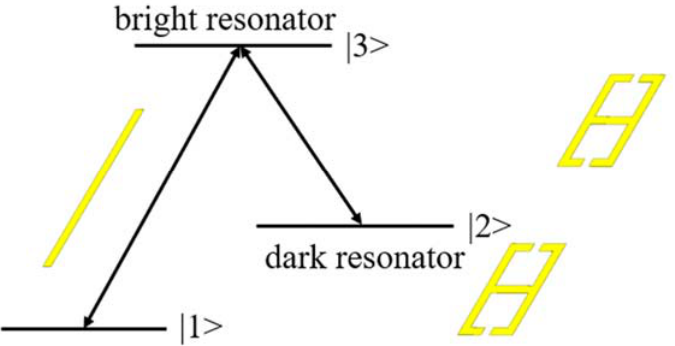
Figure 8. Three ‐ level atomic system model of the proposed EIT MTMs. Figure 8. Three-level atomic system model of the proposed EIT